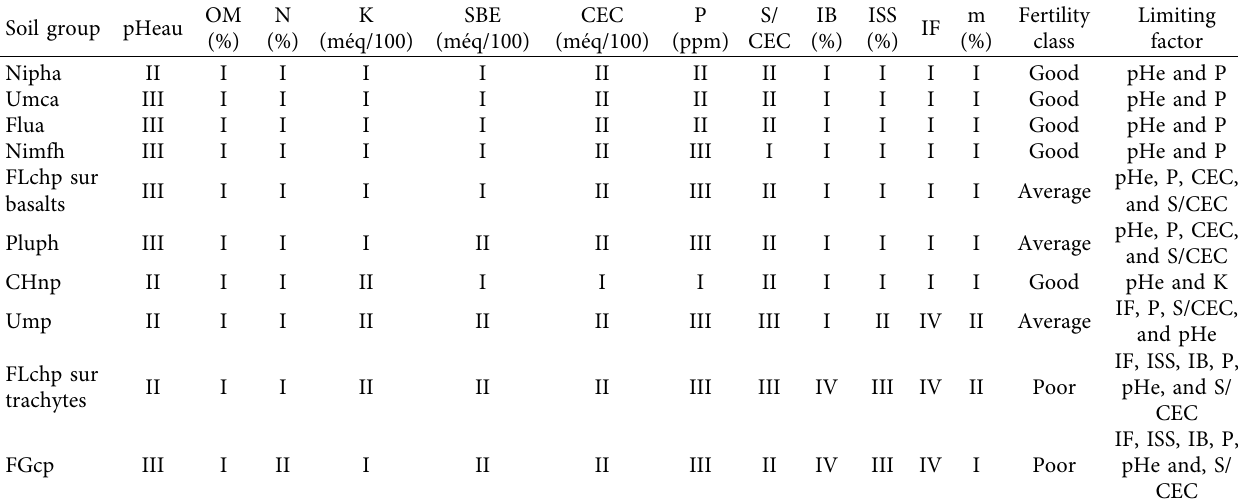
Table 4: Foumban soil fertility